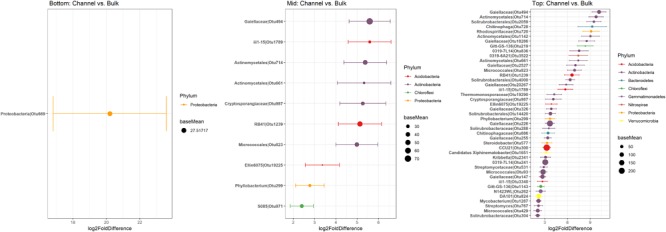
Differentially abundant OTUs between bulk and earthworm channel soil. The x-axis represents the DESeq2 estimated log2-fold difference in abundances between bulk and earthworm channel soil. Points are colored by the phylum to which they were classified and the size of the points indicates the mean abundance of that OTU among all samples.